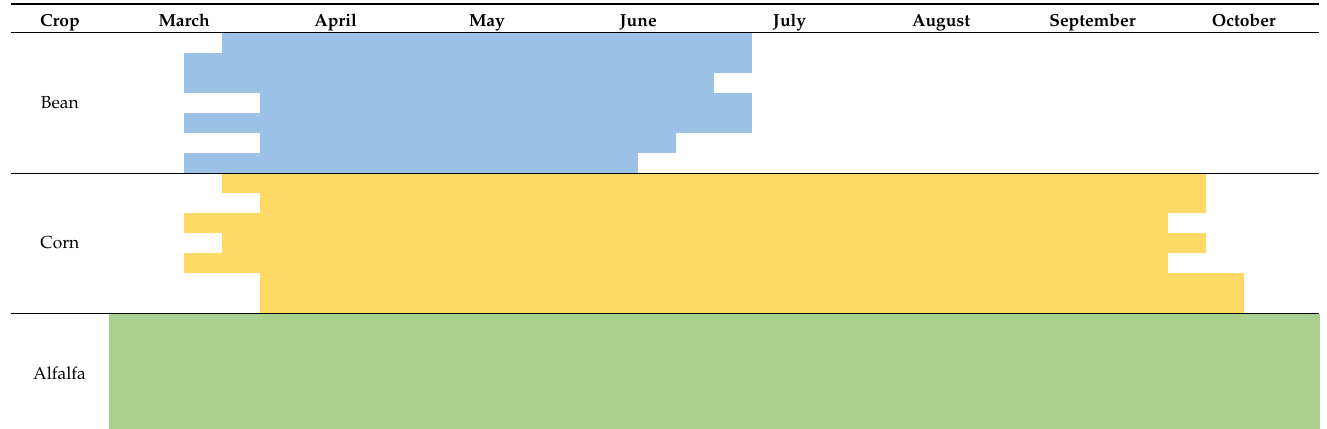
Table 2. Crop patterns of the main species planted in the Tepatepec Irrigation Module.